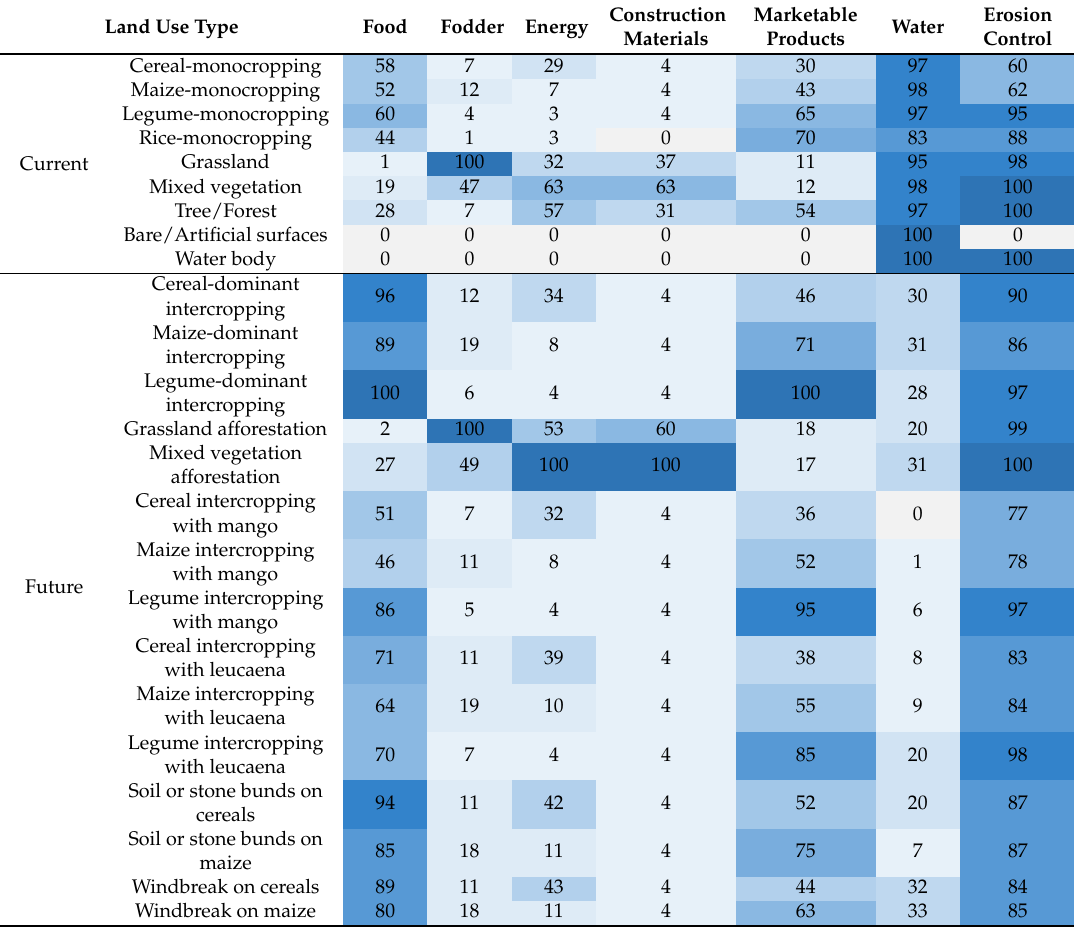
Table 4. Assessment matrix for Bolgatanga to display the relationship between current and future land use types and their potential to provide the selected ecosystem services within a scale from 0 (no provision, in white) to 100 (highest level of provision, in dark